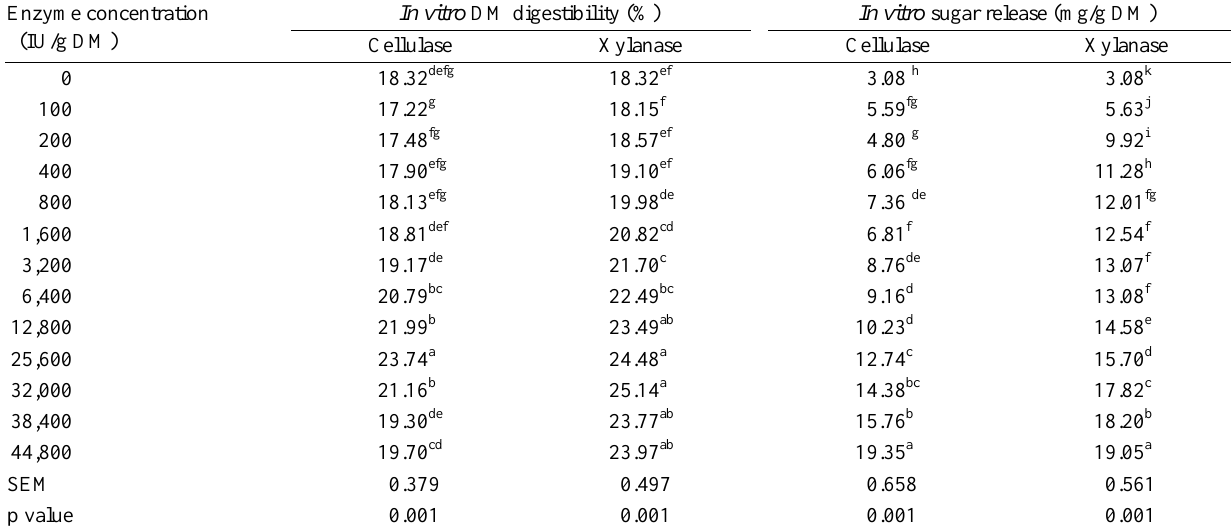
Table 1. In vitro DM digestibility (%) and total sugar release (mg/g DM) from maize stover supplemented with cellulase and xylanase at various concentrations Enzyme concentration In vitro DM digestibility (%) In vitro sugar release (mg/g DM) (IU/g DM) Cellulase Xylanase Cellulase Xylanase